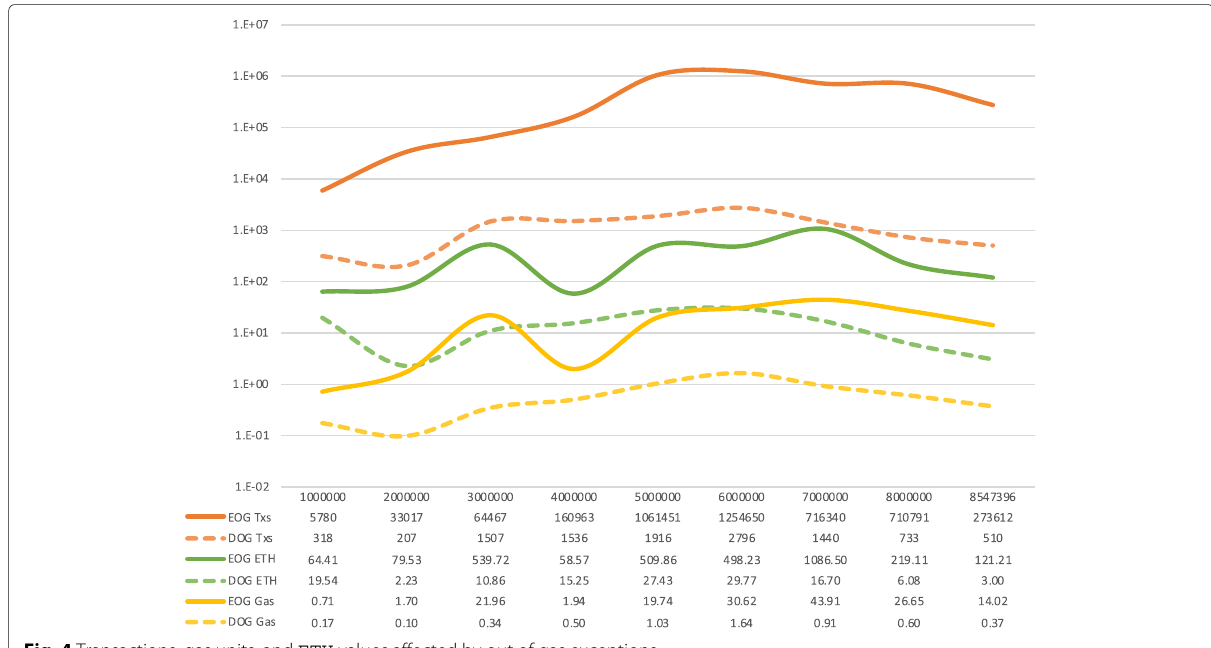
Fig. 4 Transactions, gas units, and ETH values affected by out of gas exceptions